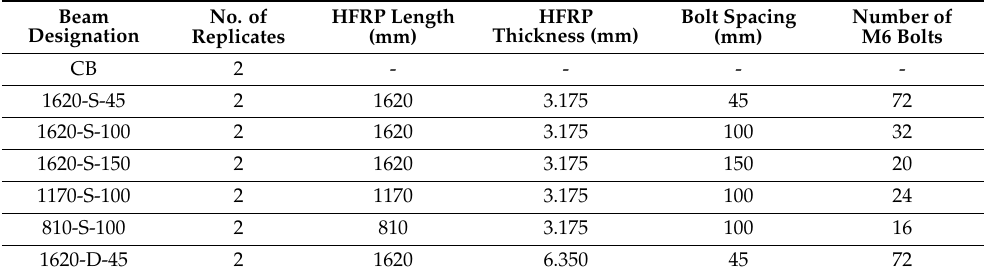
Table 1. Description of the test matrix.